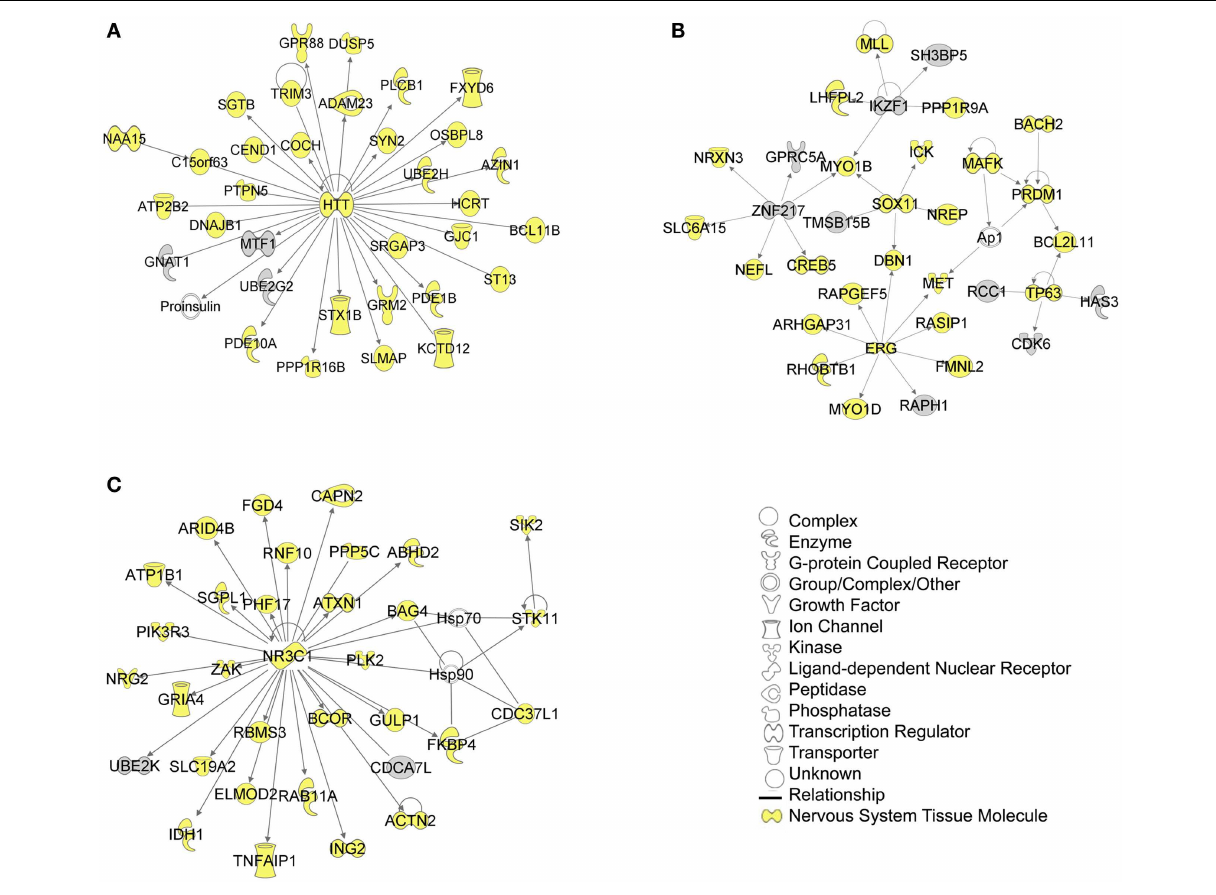
FIGURE 5 |Top 3 scoring IPA network analysis generated networks for all mapped 1150TargetScan putative targets and verified targets .The top 3 scoring networks identified were: (A) “hereditary disorder, neurological disease, skeletal and muscular disorders,” with a score of 39, (B) “cellular development, connective tissue development and function, cancer,” with a score of 39, and (C) “protein synthesis, endocrine system development and